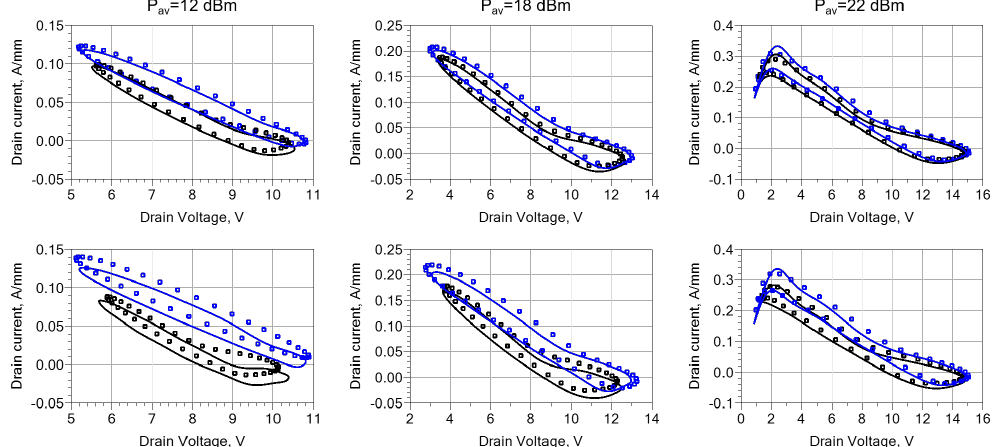
Figure 16. DLLs at the output port from TCAD (symbols) and ADS simulations with the (2NL) model (lines) with varying doping concentrations. The device is close to turn on ( P av = 12 dBm, left ), at intermediate drive ( P av = 18 dBm, center ), and in compression ( P av = 22 dBm, right ). ( Top ): − 5% (black lines and symbols); +5% (blue lines and symbols). ( Bottom ): − 10% (black lines and symbols); +10% (blue lines and